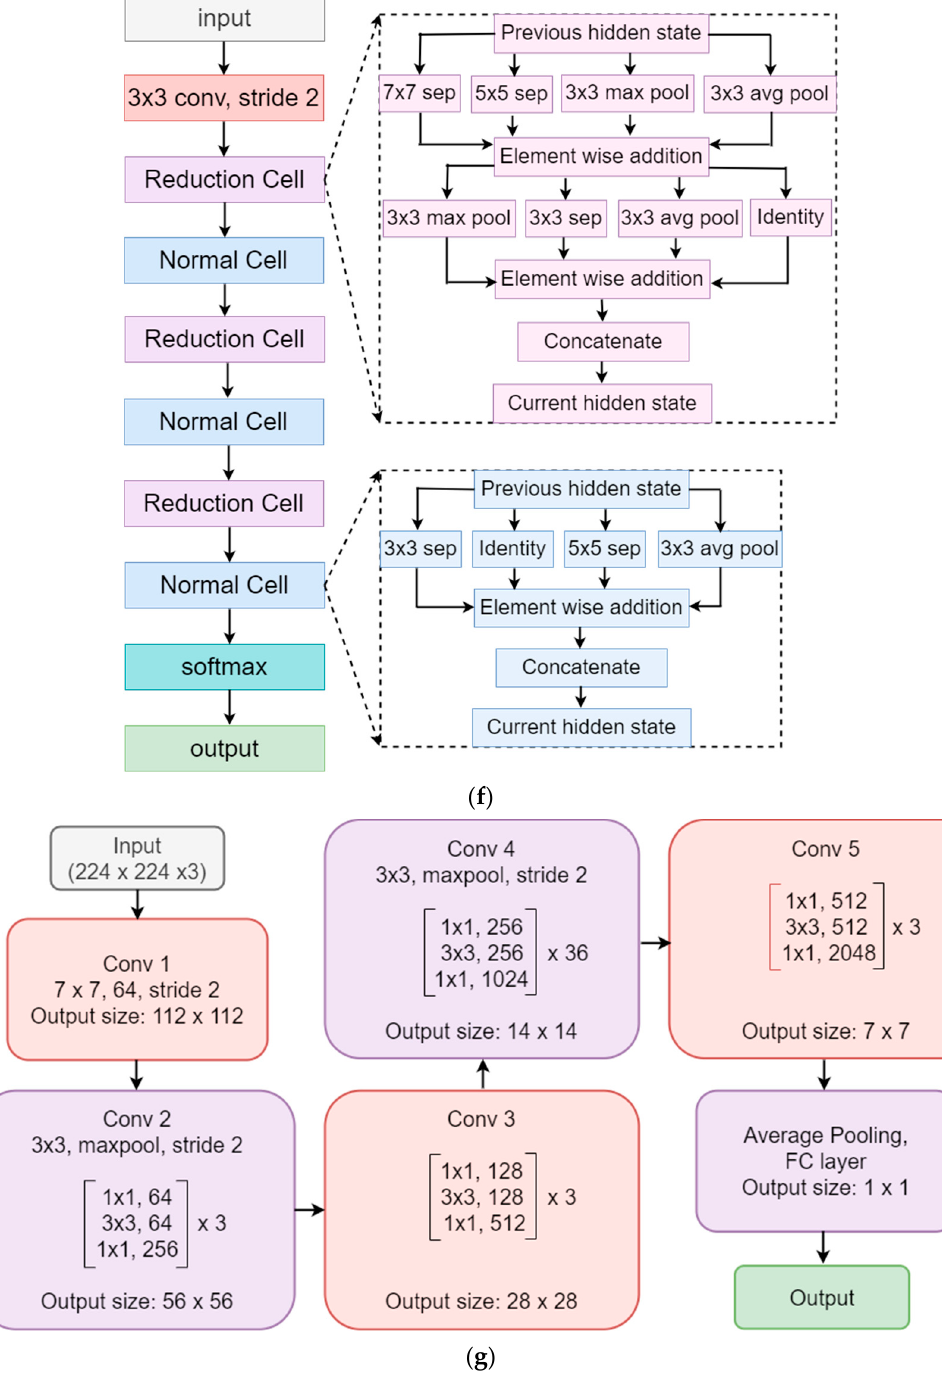
Figure 3. ( a ) VGG16 transfer learning architecture. ( b ) VGG19 transfer learning architecture. ( c ) DenseNet201 transfer learning architecture. ( d ) Xception transfer learning architecture. ( e ) Incep- tionV3 transfer learning architecture. ( f ) NasnetMobile transfer learning architecture. ( g ) ResNet152 transfer leaning architecture.